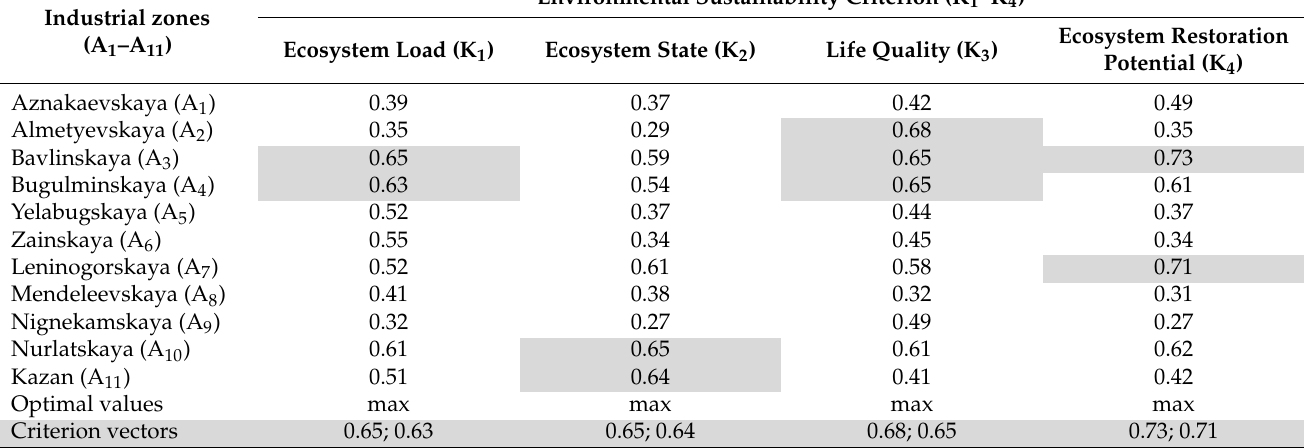
Table 2. Matrix of criteria for environmental sustainability assessment of industrial zones (level of integration 1) with the allocation of criteria vectors.